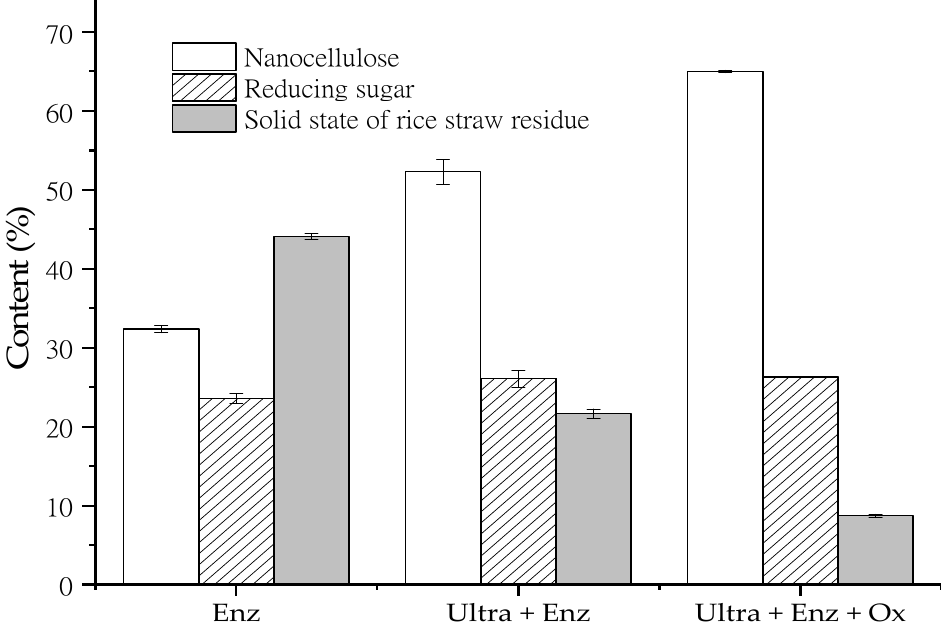
Figure 3. Nanocellulose content obtained from the intensification of rice straw cellulose hydrolysis via integrated biobased approaches.